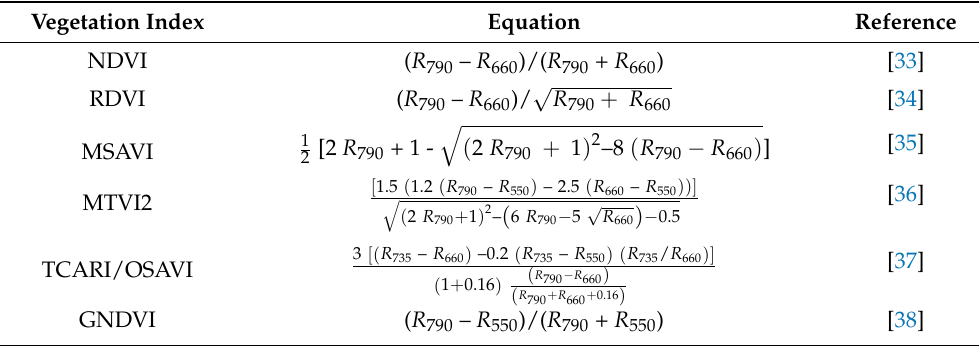
Figure 2. ( a ) Unmanned aerial vehicle (UAV) Hexacopter DJI S800 EVO used to collect the multispectral images of the experimental plots; ( b ) reference targets used for the geometric and radiometric calibrations. Table 3. Vegetation spectral indices evaluated in this